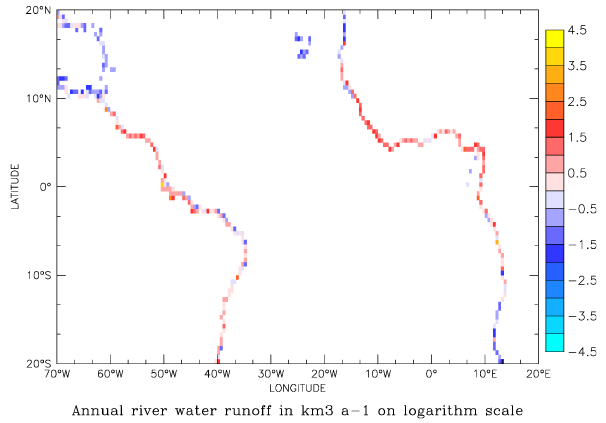
Fig. 2. Annual river freshwater input in km 3 a − 1 (logarithm scale) to the Tropical Atlantic Ocean (Döll and Lehner, 2002; Korzoun et al.,